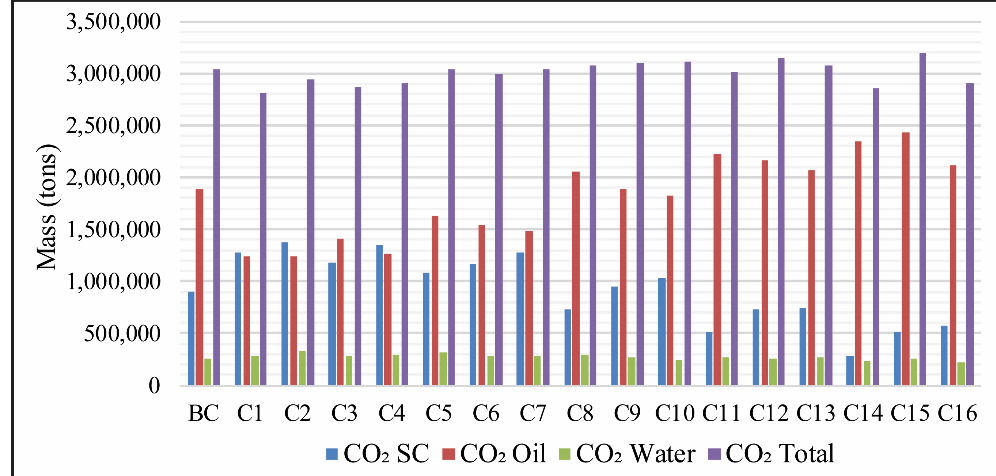
Figure 5. This chart shows CO 2 storage for each of the model permutations. ‘CO 2 SC’ is the supercritical CO 2 , ‘CO 2 Oil’ is the CO 2 and CH 4 that is dissolved in the oil phase, ‘CO 2 Water’ is the CO 2 dissolved in the aqueous phase, and ‘CO 2 Total’ is the total amount of gas, both CO 2 and CH 4 , in the reservoir. Table 3. The total mass of CO 2 stored in each phase; supercritical, dissolved in the oil phase, dis- solved in the aqueous phase. These data are the totals for the end of the simulation.